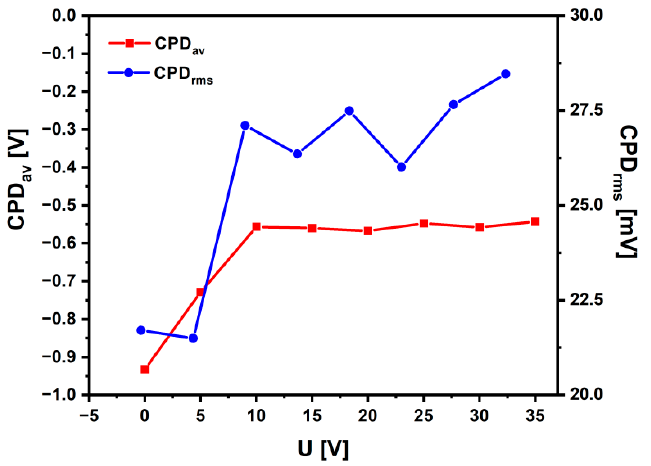
Figure 10. The arithmetic mean (CPD av ) and root mean square of height irregularities (CPD rms ) for the Ti-13Zr-13Nb alloy surface before and after anodizing.